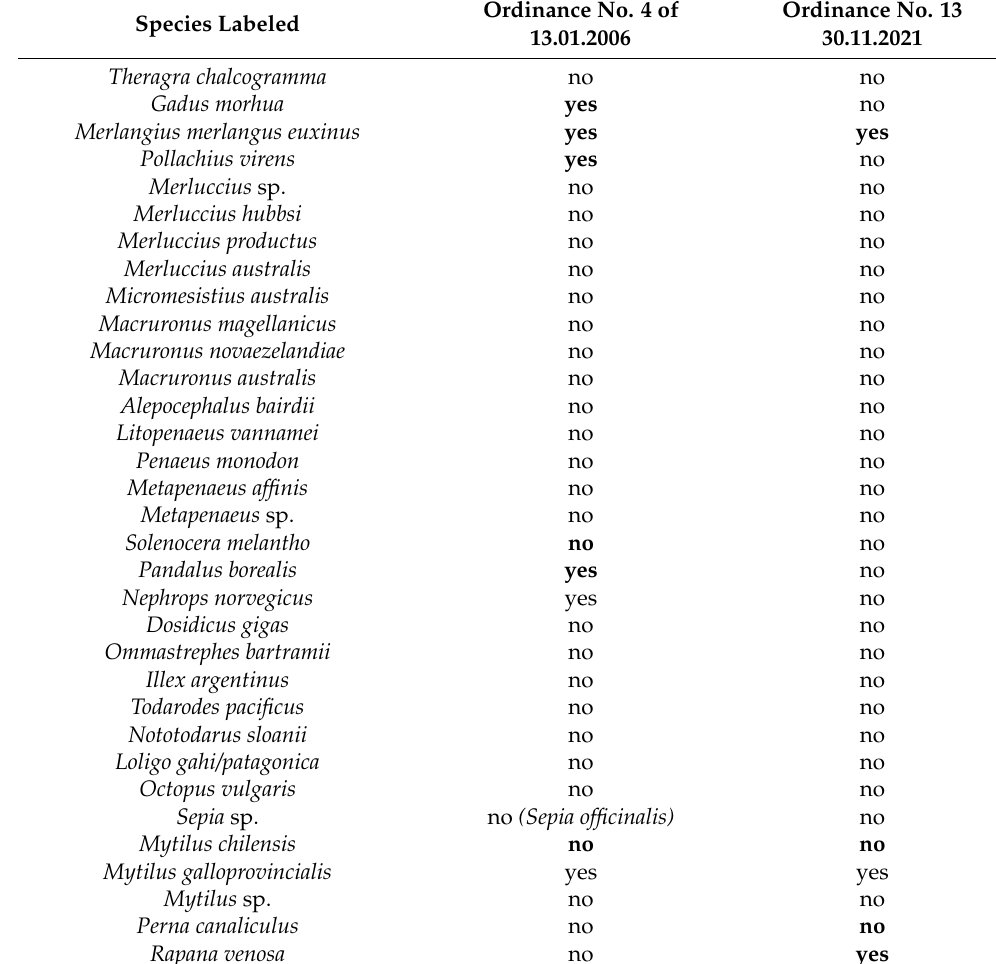
Table 3. Comparison between the scientific names found on the labels, the scientific names included in Ministerial, the official list of designations in force during the sampling period and the updated list currently in